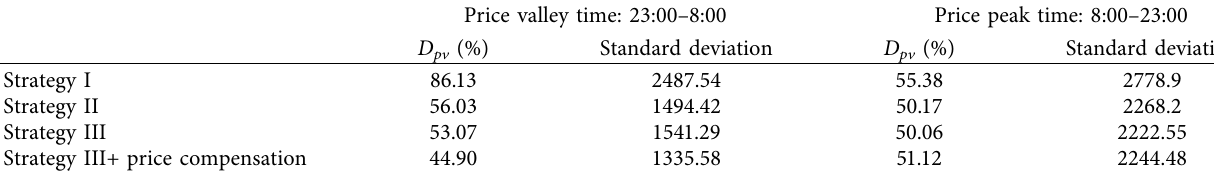
Table 5: Load optimization for diferent time periods under diferent DR strategies. Price valley time: 23:00–8:00